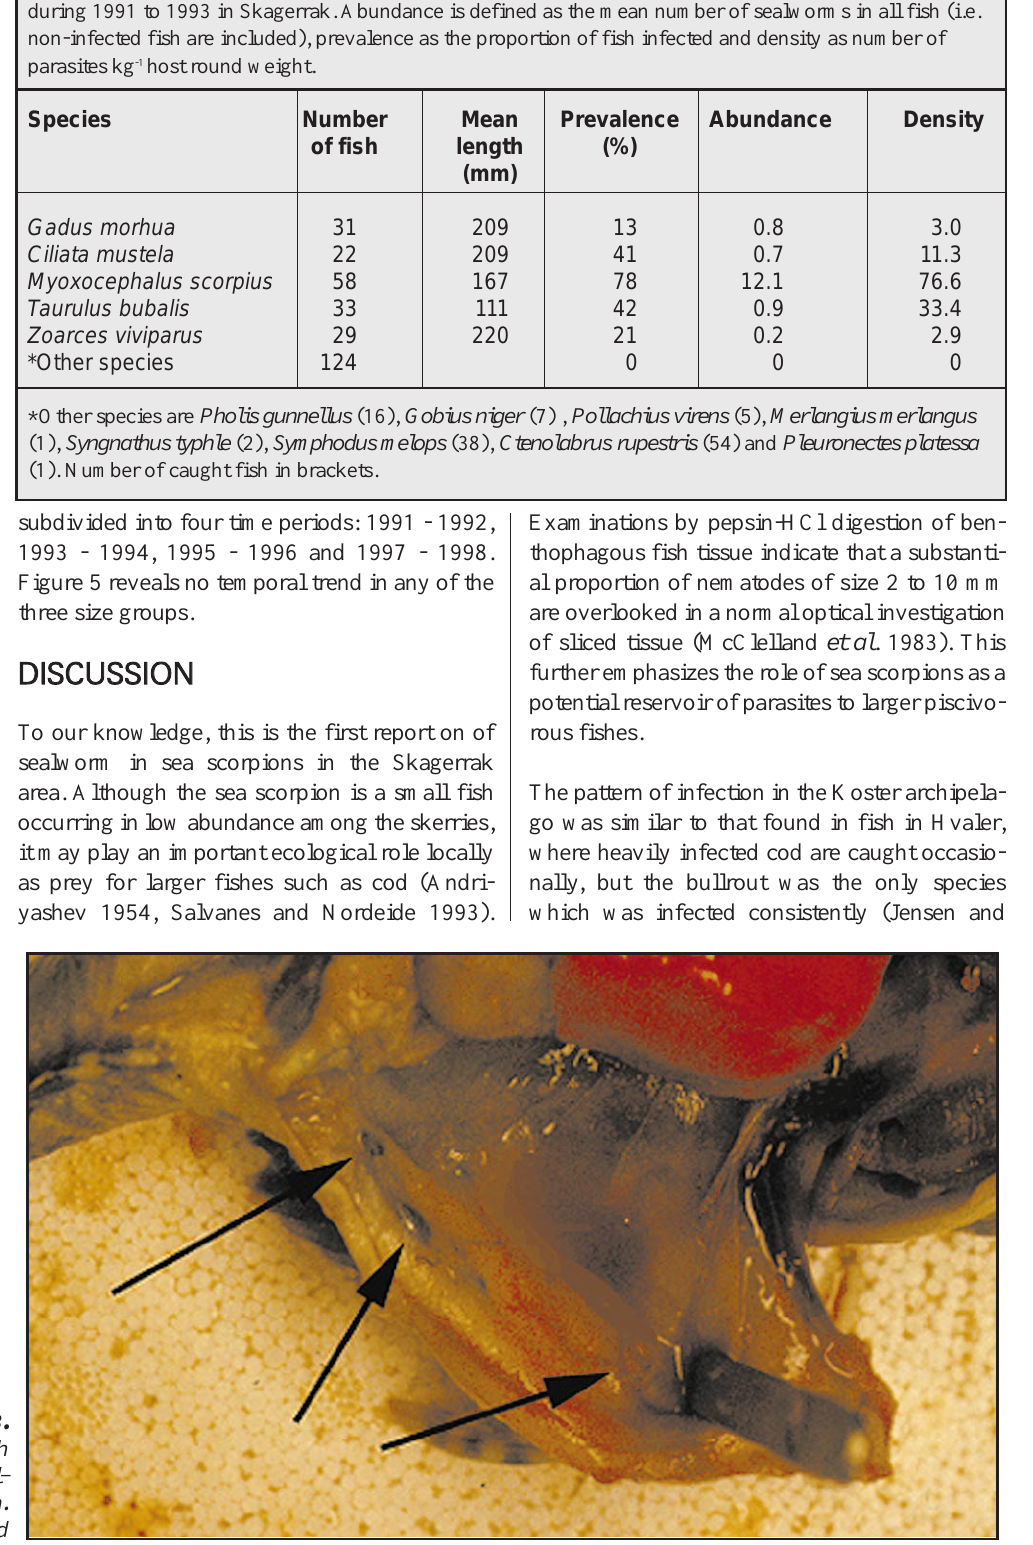
Fig. 3. Nape of a cottid fish showing larval seal- worms in the flesh. Photo: S-G.